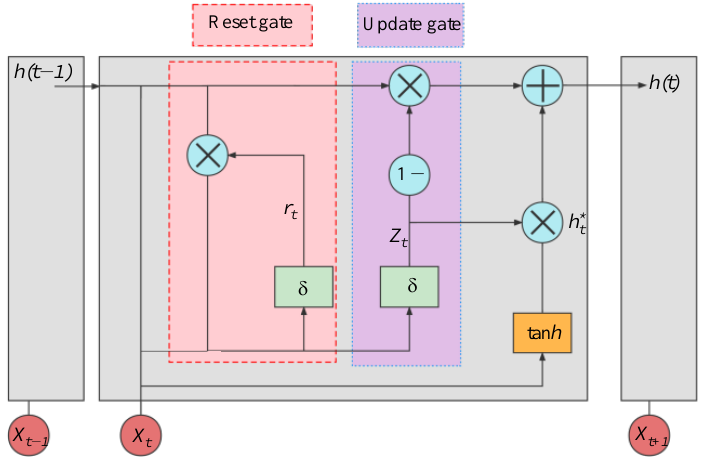
Figure 13. The network structure of the GRU model. The updated equation for the parameters of the GRU model is